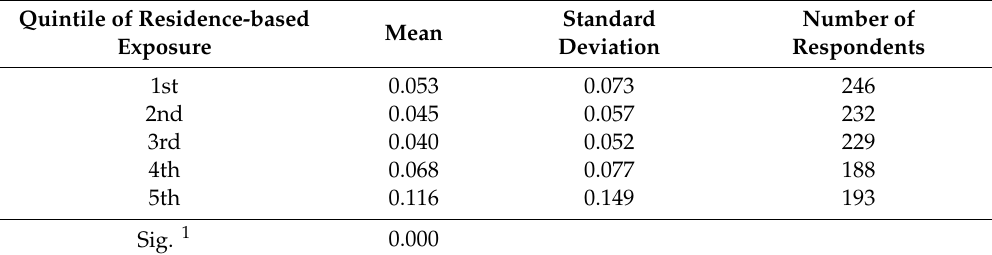
Table 3. Analysis of variance (ANOVA) for the overall deviation index ( D ).